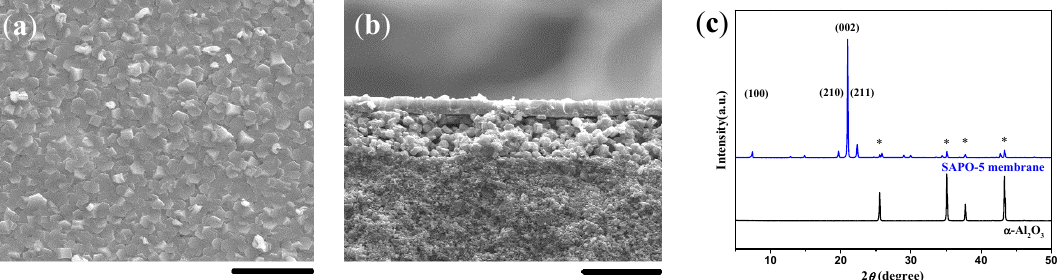
Figure 1. ( a ) Top view and ( b ) cross-sectional SEM images together with ( c ) the corresponding XRD pattern for the double-layer SAPO-5 membrane induced by a medium molecular weight (MMW) chitosan layer using aluminum isopropoxide (AIP) as the Al source. Scale bars correspond to 20 μ m in SEM images. The asterisks in XRD patterns mark the peaks originating from the α -Al 2 O 3 substrate.